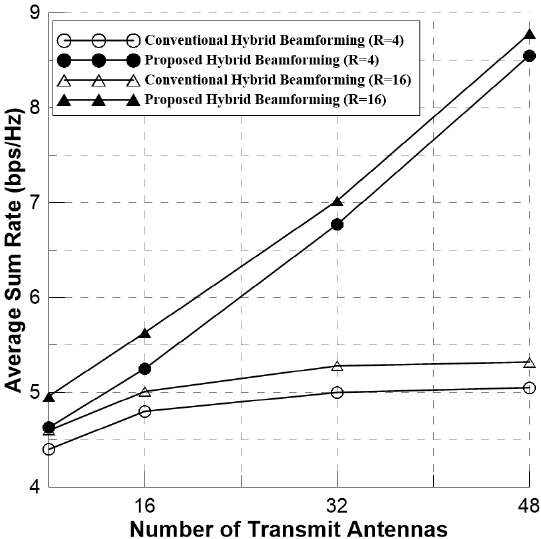
Figure 13. The average sum rate of the hybrid beamforming schemes according to the number of transmit antennas, SNR = 8 dB.